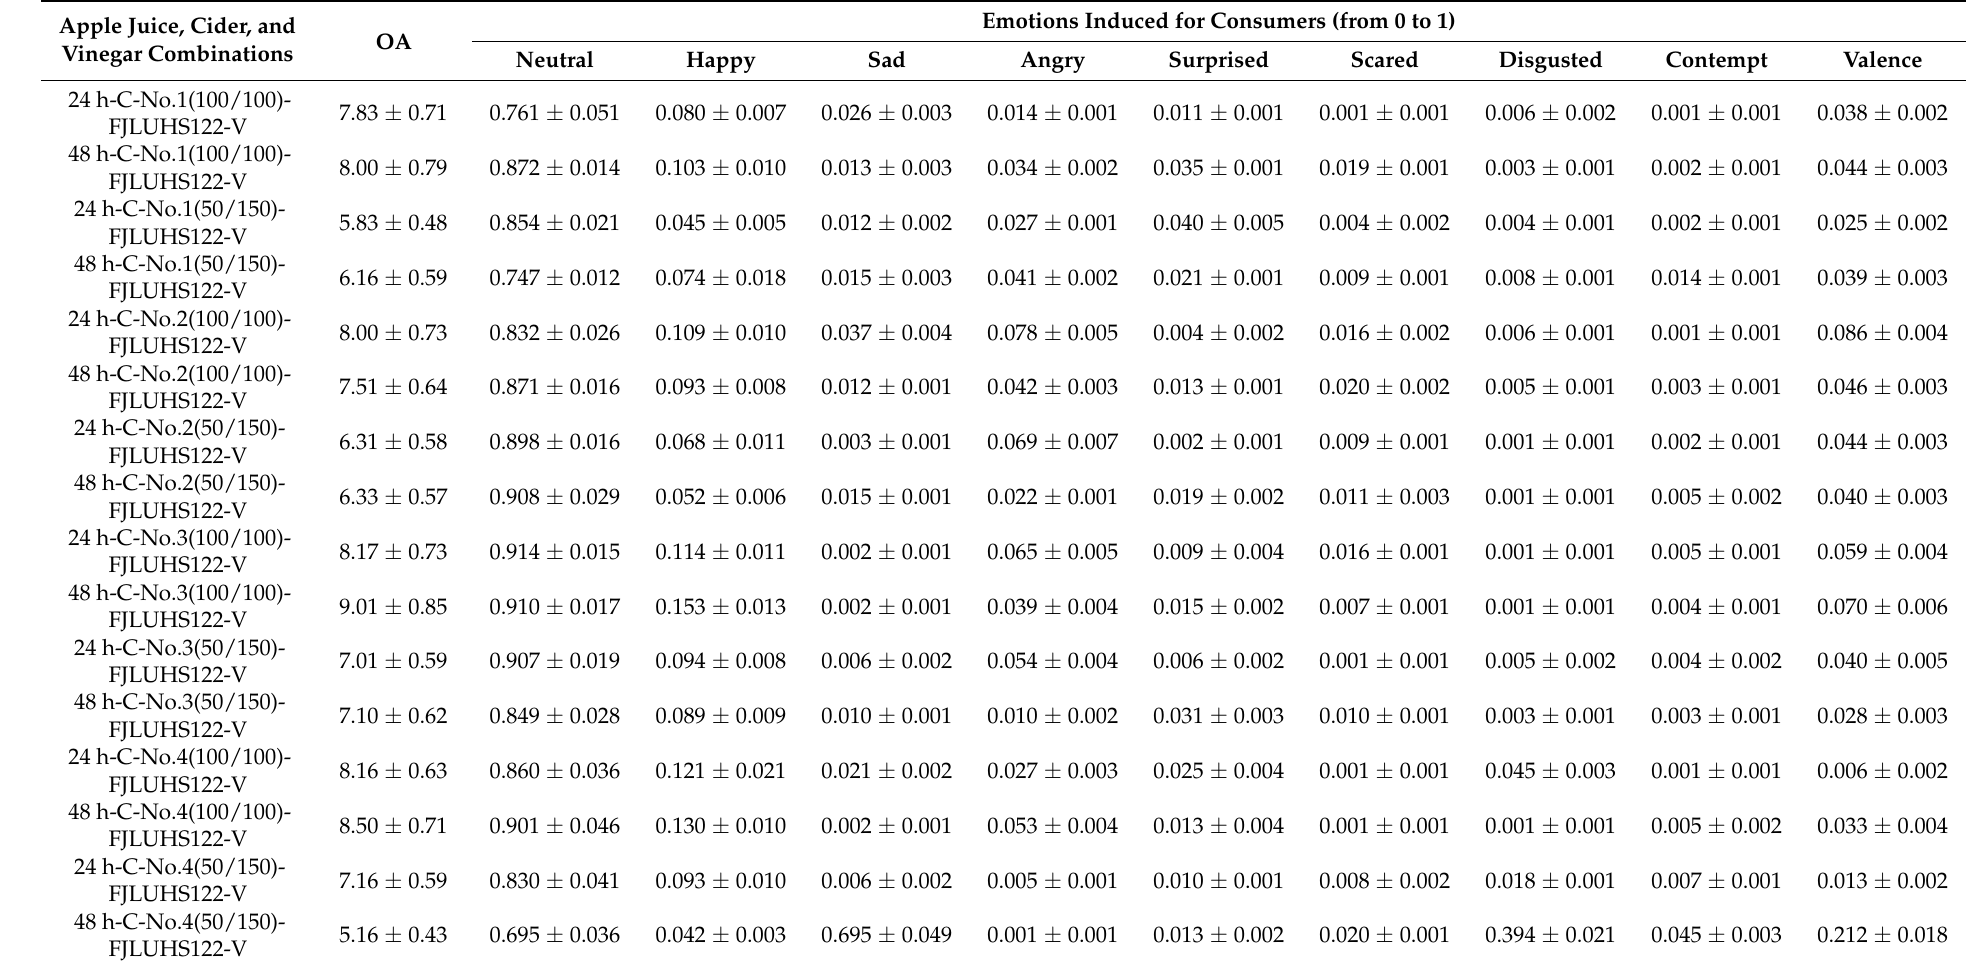
Table 9. Overall acceptability and emotions induced for consumers by apple juice, cider, and vinegar